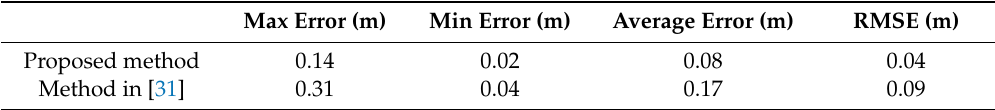
Table 6. Statistics of the clearance calculation